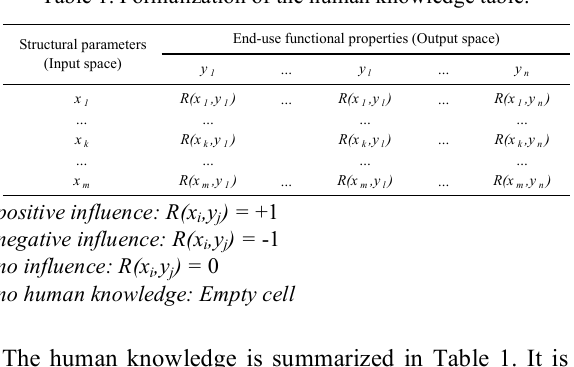
As shown in Fig. 3, |I intervals, intersection and union of A related to C